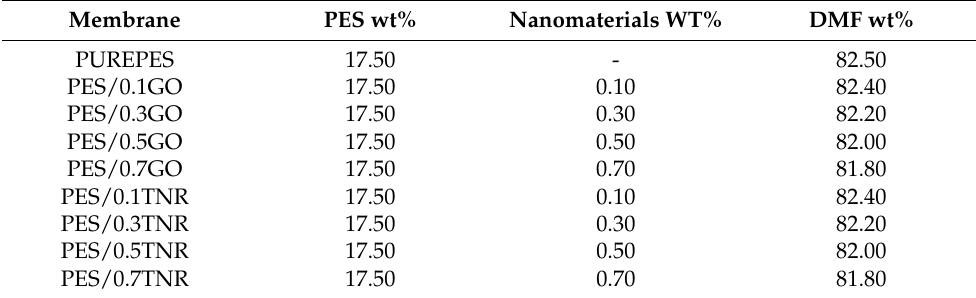
Table 1. The concentration of nanomaterial in synthesized